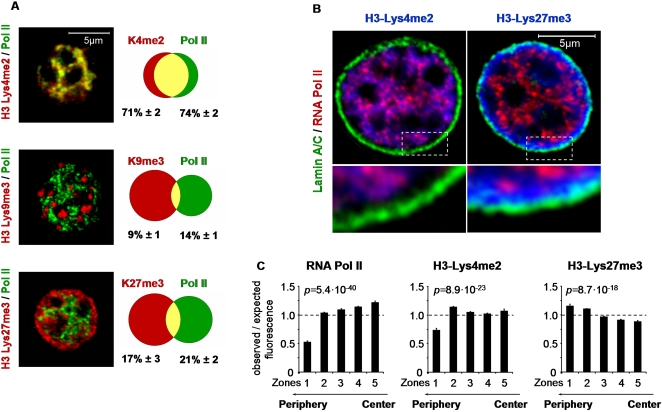
Methylated histone H3 marks exhibit a non-random subnuclear distribution.(A) Dual immunofluorescence confocal analysis of domains enriched in H3-Lys4me2, H3-Lys9me3, and H3-Lys27me3 (red) compared with RNA polymerase II (green) in interphase wild-type hepatocyte nuclei. Adjacent Venn diagrams display percentages of colocalization (mean±SEM from 20 nuclei) of signals exceeding the 75th percentile of nuclear signal intensity in wild-type nuclei. (B) Triple immunofluorescence of RNA polymerase II (red), lamin A/C (green) and either H3-Lys4me2 or H3-Lys27me3 (blue) in hepatocytes. Insets below show peripheral nuclear segments at higher magnification. (C) Erosion analysis of the nuclear distribution of RNA polymerase II, H3-Lys4me2, or H3-Lys27me3. Nuclei were subdivided into 5 concentric zones, and total nuclear fluorescence intensities were determined for each epitope using non-thresholded images. The graphs indicate the percentages of total nuclear fluorescence intensities observed in each zone (mean±SEM). The values were normalized to the relative nuclear areas occupied by the different zones, so that a value of 1 was obtained if the percentage is as expected in case of unbiased distribution. At least 20 nuclei were analyzed in each case. Significance values for the comparison between the 5 zones for each of the 3 epitopes were obtained by ANOVA.